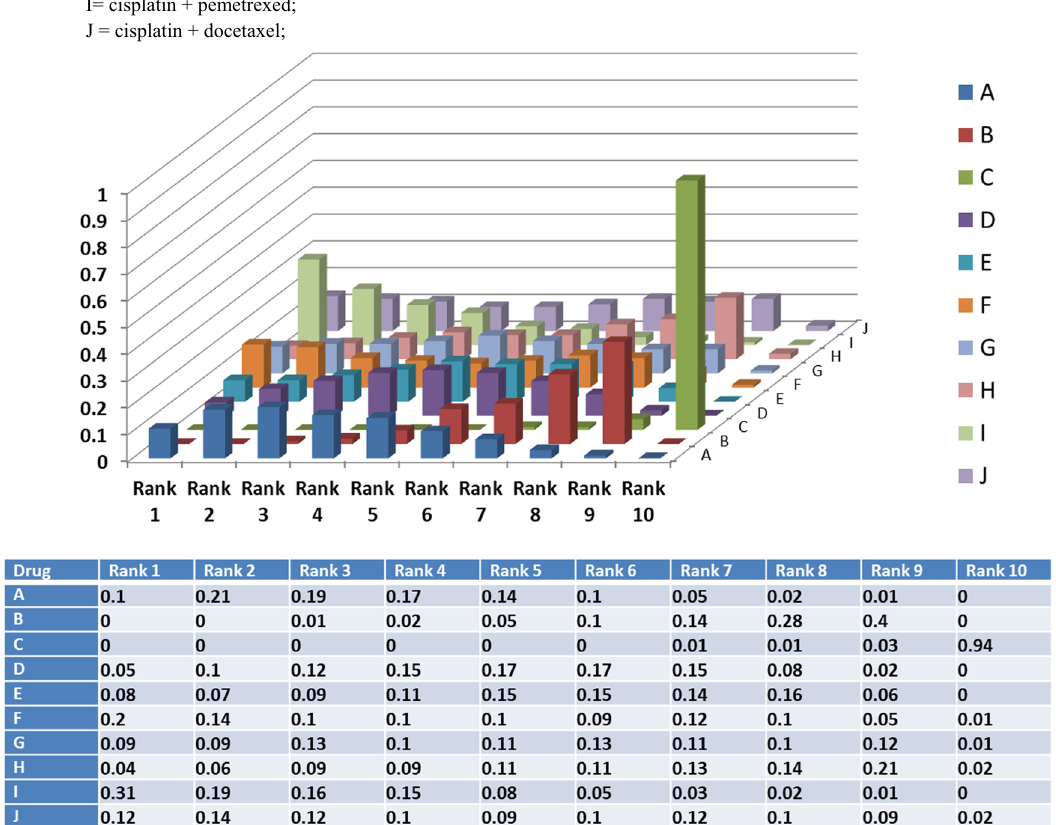
Figure 6: Bar plot of the rank probability of the 10 fi rst - line chemotherapy regimens for advance NSCLC. A = cisplatin + gemcitabine, B = carboplatin + gemcitabine, C = gemcitabine, D = carboplatin + paclitaxel, E = paclitaxel + gemcitabine, F = carboplatin + docetaxel, G = gemcitabine + vinorelbine, H = carboplatin + pemetrexed, I = cisplatin + pemetrexed and J = cisplatin +